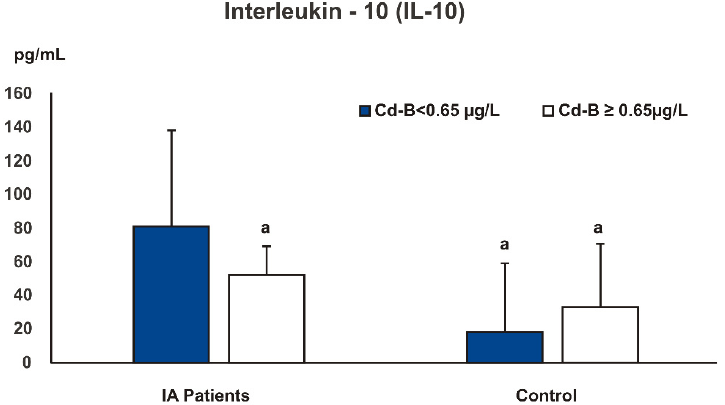
Figure 2. Serum interleukin 10 in inflammatory arthritis patients and controls depending on blood cadmium concentrations (Cd ‐ B). a significant difference ( p < 0.05) versus patient group with lower blood cadmium levels, Cd ‐ B < 0.65 μ